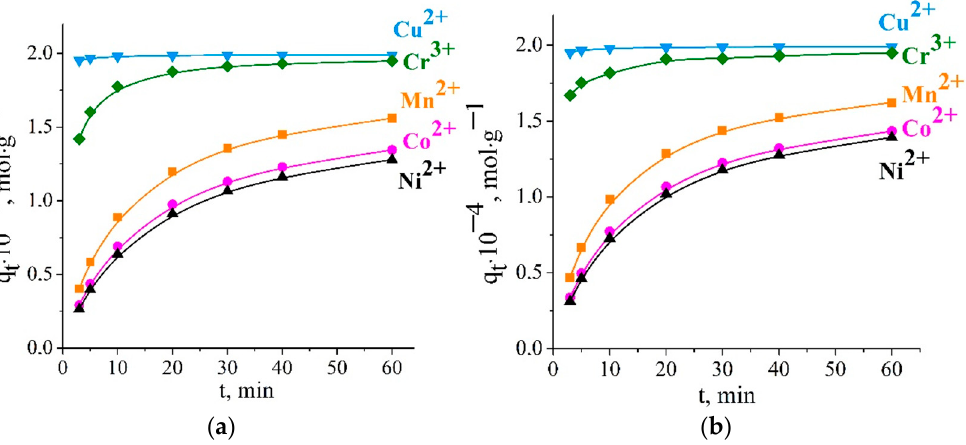
Figure 2. Sorption kinetics of Cu 2+ , Co 2+ , Ni 2+ , Mn 2+ , and Cr 3+ ions on Li-TiOP at 298 K ( a ) and 313 K ( b ).